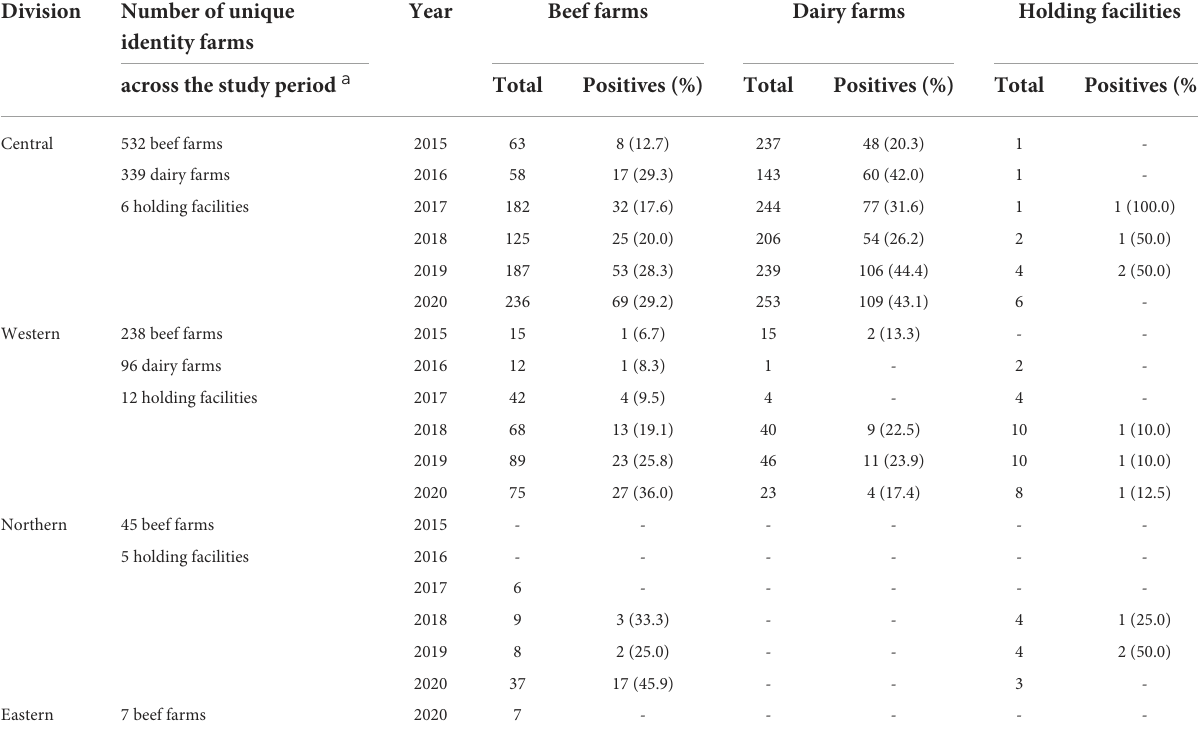
TABLE 5 Number of farms tested by the BTEC program and proportion of bTB positive by farm type from 2015 to 2020 across the four Divisions of Fiji.